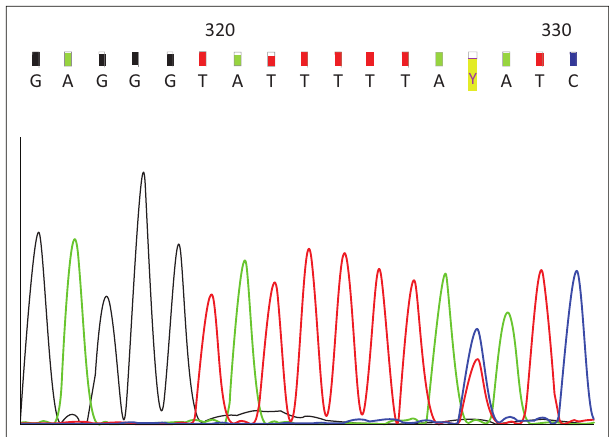
FIGURE 2: Electropherogram demonstrating heterozygosity for the c.282C>T (p.Y94Y) single nucleotide variation, Western Cape, South Africa, 2013–2016. Single nucleotide variants depicted by the red ‘Y’ highlighted in yellow.